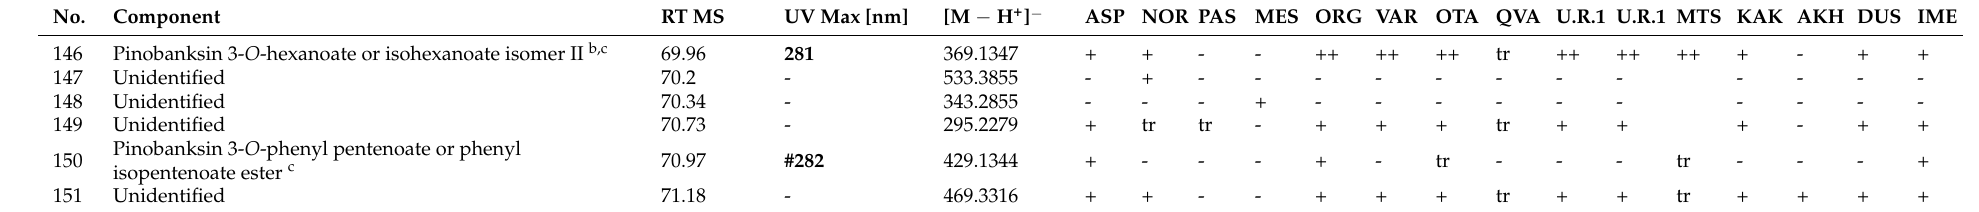
Table legend: UV max [nm]—maximum of UV absorption, higher maximum is bolded; ASP—Aspindza; NOR—Norio; PAS—Pasanauri; MES—Mestia; ORG—Orgora; VAR—Vardzia; OTA—Ota; QVA—Qvakhreli U.R.1—unknown region 1; U.R.2—unknown region 2; MTS—Mtskhete; KAK—Kakheti; AKH—Akhatsikhe; DUS—Dusheti; IME—Imereti; #—UV spectrum is weak due to low concentration; a component identified by comparison with standard; b component identified by comparison with literature; c component identified by prediction of mass fragment and UV spectrum; * component tentatively identified; iw component does not produce or produces low/trace amount of ions in negative mode; - component